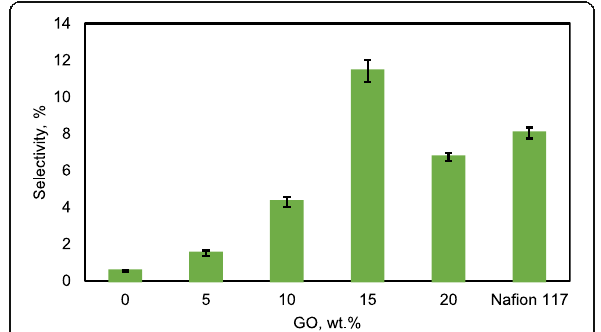
Fig. 16 Selectivity of QPVA membrane, QPVA/GO composite membrane and Nafion